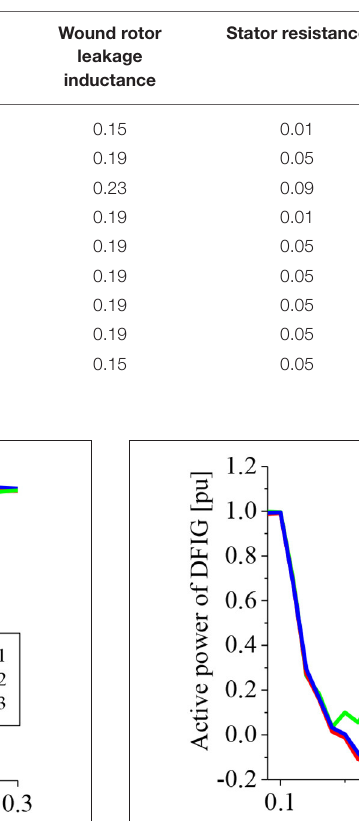
TABLE 1 | DFIG machine parameters (Hitachi Heavy Equipment Construction, 2012).